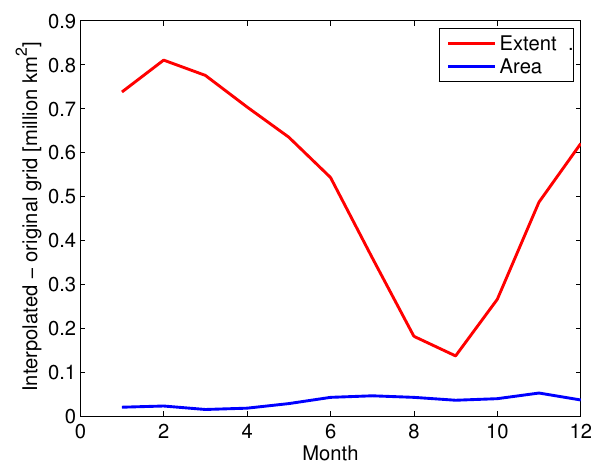
Fig. 10. Mean difference of sea-ice area and sea-ice extent between the original 25km EASE-Grid and all CMIP5 model grids through- out the year 2007. For each month, the Bootstrap-derived sea-ice concentration was interpolated onto all individual model grids, from which then sea-ice extent and sea-ice area were calculated. The dif- ferences of all grids relative to the original EASE-Grid were aver- aged for this